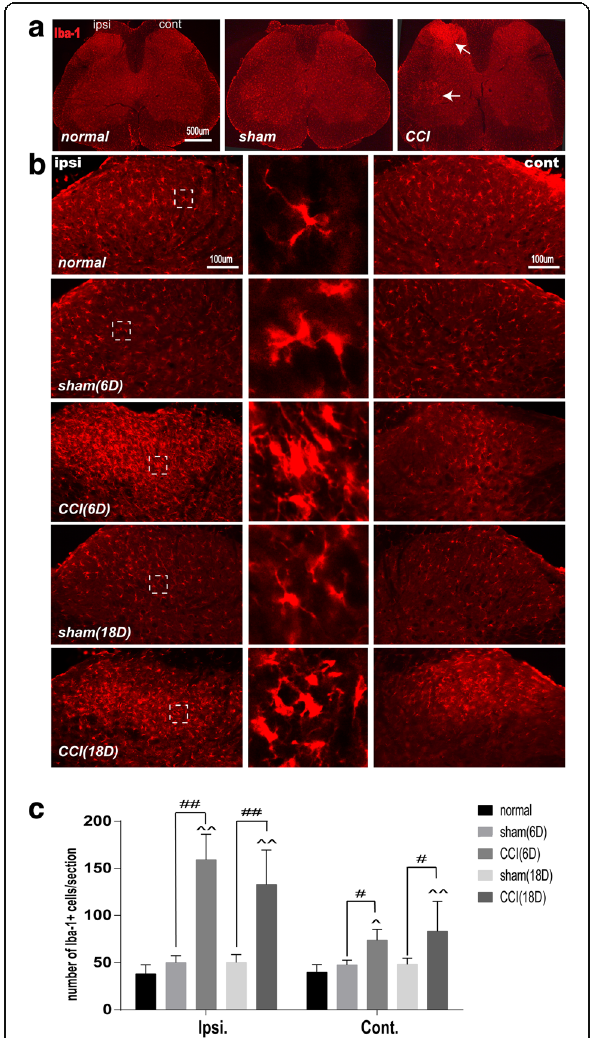
Fig. 2 Numbers of Iba-1-labeled microgliacytes in ipsilateral and contralateral dorsal horns (DHs) of lumbar spinal cord (L4 – 5) on day 6 and 18 after surgery in the normal control (normal), sham operation (sham), and CCI model (CCI) groups. a Iba-1-labeled microglia (indicated by arrowheads) in the DHs and anterior horns of lumbar spinal cord on the ipsi. Side of CCI on day 6 after surgery. b An increase of numbers of the activated microgliacytes mainly distributing in the superficial layers of ipsi. and cont. DHs on day 6 (denser) and day 18 (lesser) in the 3 groups. Central column: the magnified activated microgliacytes derived from the dashed rectangular box of each picture on the left side. Ipsi: ipsilateral, Cont: contralateral. D: day. c Histograms showing the number of Iba-1- labeled microgliacytes in the ipsilateral and contralateral DHs of lumbar spinal cord on day 6 and 18 after sham and CCI-operation in the 3 groups (mean±SD, n =6/group). ^ P <0.05, ^^ P <0.01, vs the normal group; # P<0.05, ## P<0.01, vs the sham group